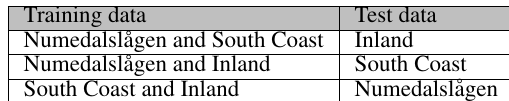
Table 1. Flood events used to construct training data.